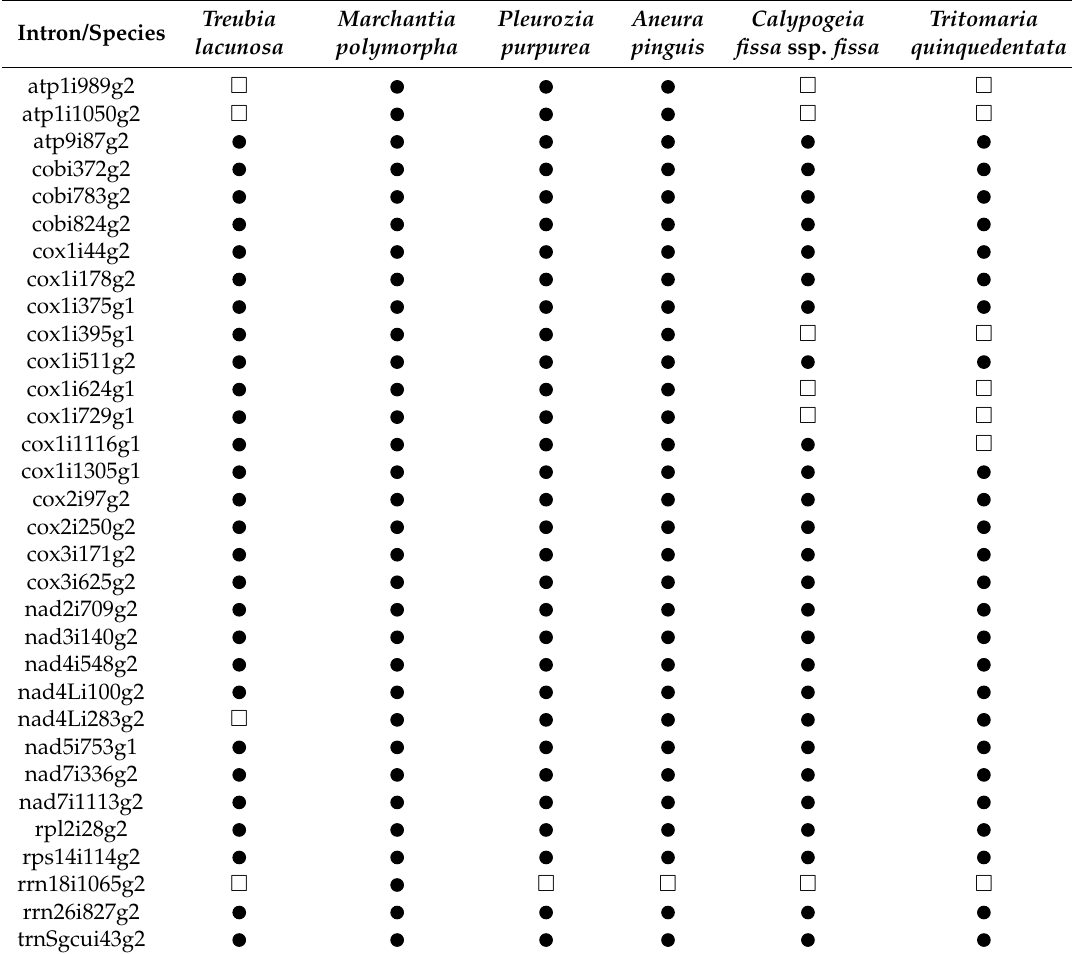
Table 3. Intron contents in liverwort mitochondrial genomes. The black circle indicates the presence of an intron. The white square indicates an intron lacking. Intron nomenclature follows Dombrovska and Qiu [57] and Knoop